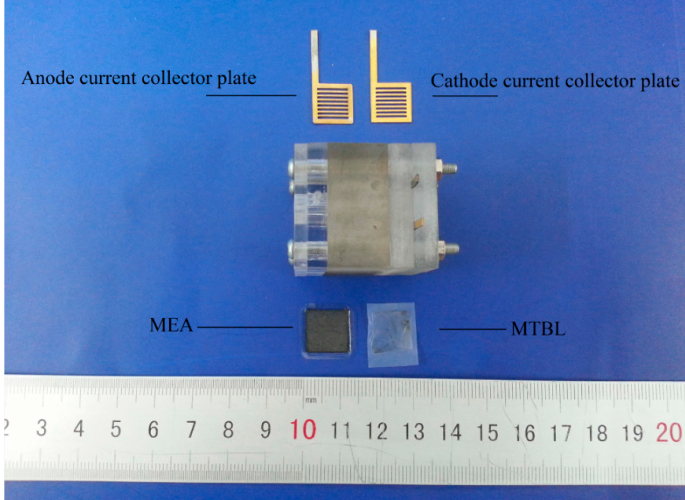
Figure 4. Photograph of the whole μ -DMFC designed in this